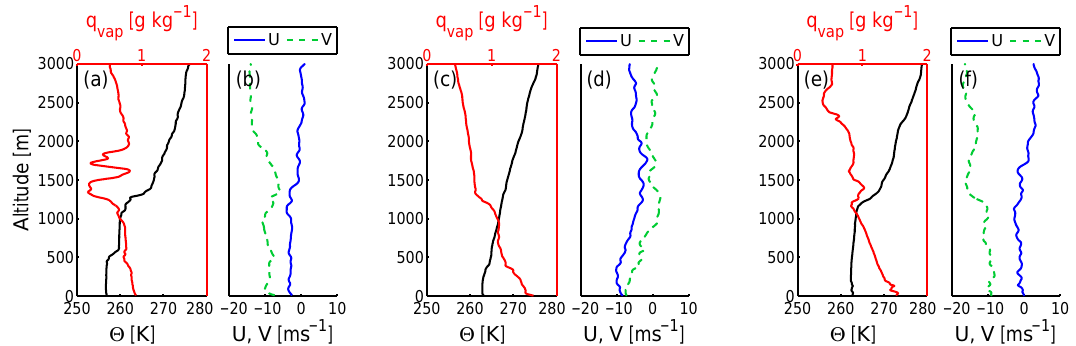
Figure 3. Potential temperature, vapour mixing ratio, and wind speed profiles measured by the three dropsondes used to initialise the LEM in this study. (a–b) Dropsonde 1 released over the sea ice during flight B762. (c–d) Dropsonde 2 released over the MIZ during flight B764. (e–f) Dropsonde 3 released over the ocean during flight B762. Table 2. Summary of cloud observations for each of the three cases considered. Values quoted are averaged quantities, with 1 σ in brackets.